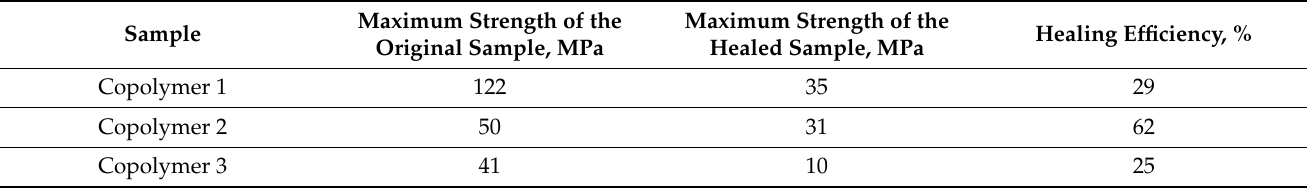
Table 4. Assessment of healing efficiency in relation to the maximum strength.